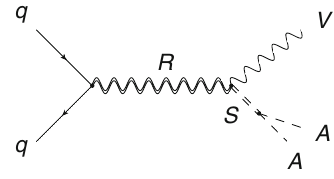
Fig. 8 Sample diagram for a R → V S